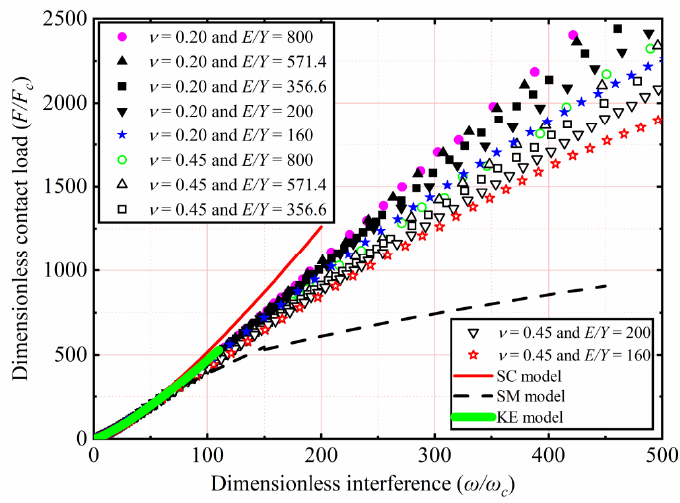
Figure 5. F / F c as a function of ω / ω c for different Y , ν , and E / Y > 133.3. The effects of Y and ν shown in Table 3 on F / F c as a function of ω / ω c are analyzed. Here E is a constant value equal to 200 GPa, while ν ranges from 0.2 to 0.45. With Y ranging from 1.25 to 0.25 GPa, corresponding to the E / Y ratios ranging from 160 to 800, which are all greater than 133.3, respectively. Here only the results of ν = 0.2 and 0.45 for E / Y = 160, 200, 356.6, 571.4, and 800 are selected and plotted in Figure 5. In the present interference domain, the SM model distinctly underestimates F / F c . For 1< ω / ω c ≤ 110, the results indicate that the similarity with the KE model, F / F c is independent of the Y and ν of the material. For 110 < ω / ω c ≤ 500, the present results show that the value of F / F c decreases Table 4. Parameters in Equations (9) and (10). with an increasing Y . In addition, as ω / ω c increases for the material with a lower ν , the higher the F / F c is for the fixed E / Y . In this work, the curve fitting of simulation data is carried out. For 133.3 < E / Y ≤ 800, 0.2 ≤ ν ≤ 0.45, and 1 < ω / ω c ≤ 500, the